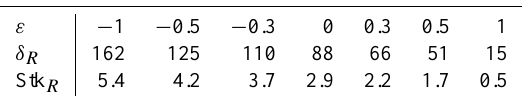
Table 1. Frictional layer depth and stokes number for a 1ms − 1 tidal current with different ellipticities at 54 ◦ N and 30 m water column depth.